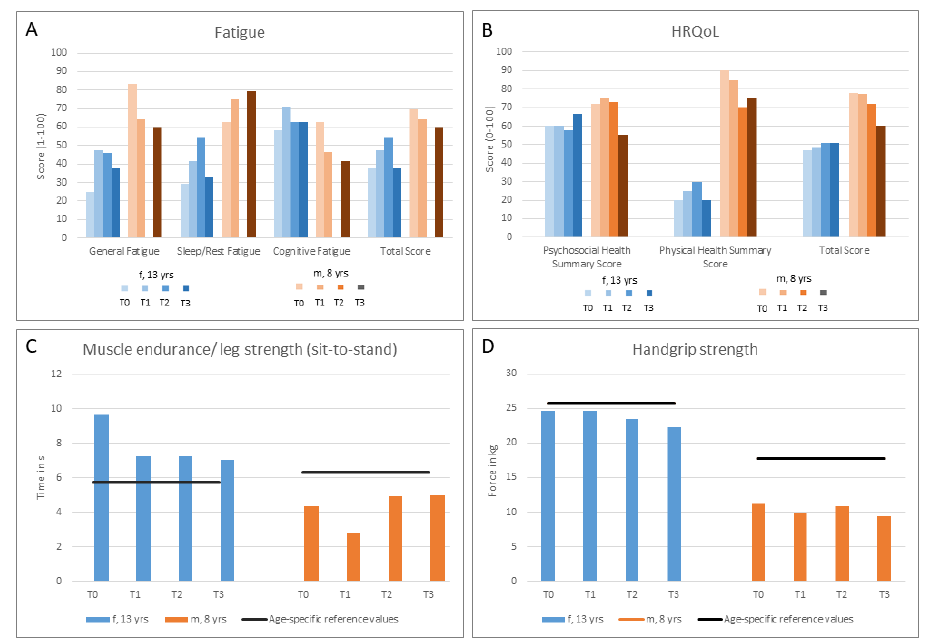
Figure 2. Results of psychological and physical assessments at different time points (T0–T3) for the 13-year-old female (f, 13 yrs) and the 8-year-old male (m, 8 yrs). ( A ) Subscales and total score for Multidimensional Fatigue Scale. Higher scores indicate reduced problems with fatigue. Missing values for T2 for m, 8 yrs. ( B ) Subscales and total score for Health Related Quality of Life (HRQoL). Higher scores indicate better HRQoL. ( C ) Muscular endurance/leg strength compared to age- and gender-specific reference values (5× Sit-to-stand). Lower times (s) indicate better results. ( D ): Maximal isometric handgrip strength compared to age- and gender-specific reference values. Higher results indicate more force.